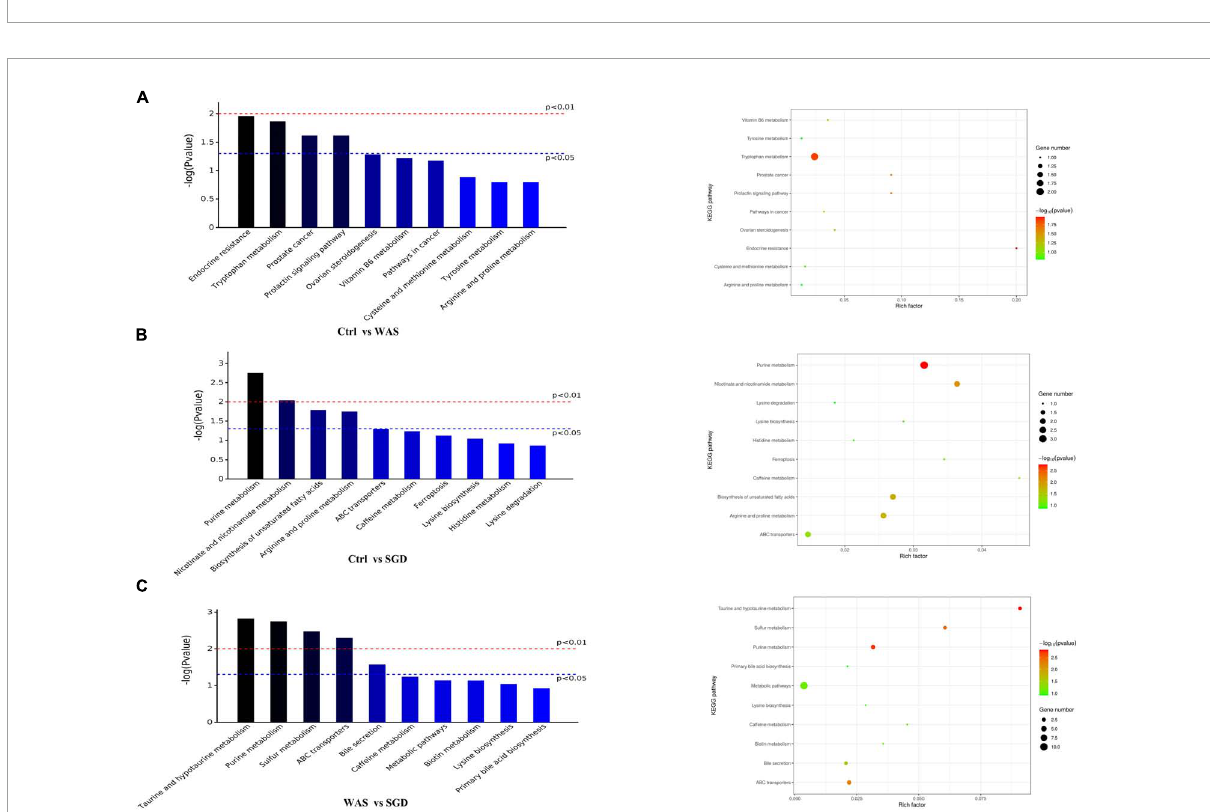
FIGURE9 Metabolic profiling: KEGG pathway. (A) KEGG pathways with significant differences between control and WAS groups. (B) KEGG pathways with significant differences between control and SGD groups. (C) KEGG pathways with significant differences between WAS and SGD groups. (Left) Histogram of enriched KEGG pathways statistics. The x -axis indicates KEGG metabolic pathways with significant differences and the y -axis indicates the P value of each KEGG pathway. (Right) Bubble chart of enriched KEGG pathways statistics. Rich factor is the ratio of the differentially expressed gene number to the total gene number in a certain pathway. The color and size of the dots represent the range of the –log( P -value) and the number of genes mapped to the indicated pathways, respectively. pathways that P < 0.05 are shown in the